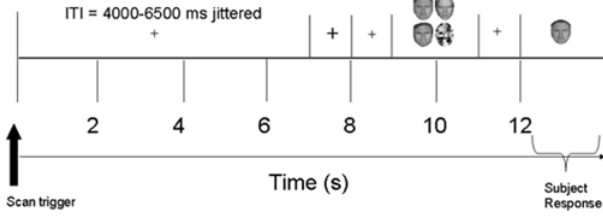
Figure 1. Here is an example trial procedure (load 3 shown as illustration). Between one and four faces (all expressing either angry, happy, or neutral emotion) were shown for encoding for 2000 ms, followed by a 1000 ms blank retention/maintenance phase, and a 2000 ms retrieval phase in which participants stated whether a single probe face had been present or not in the previous display. All faces in any one trial (i.e., at encoding and retrieval) displayed the same emotion. A jittered inter-trial interval (ITI) of between 4000 ms and 6500 ms separated each trial.